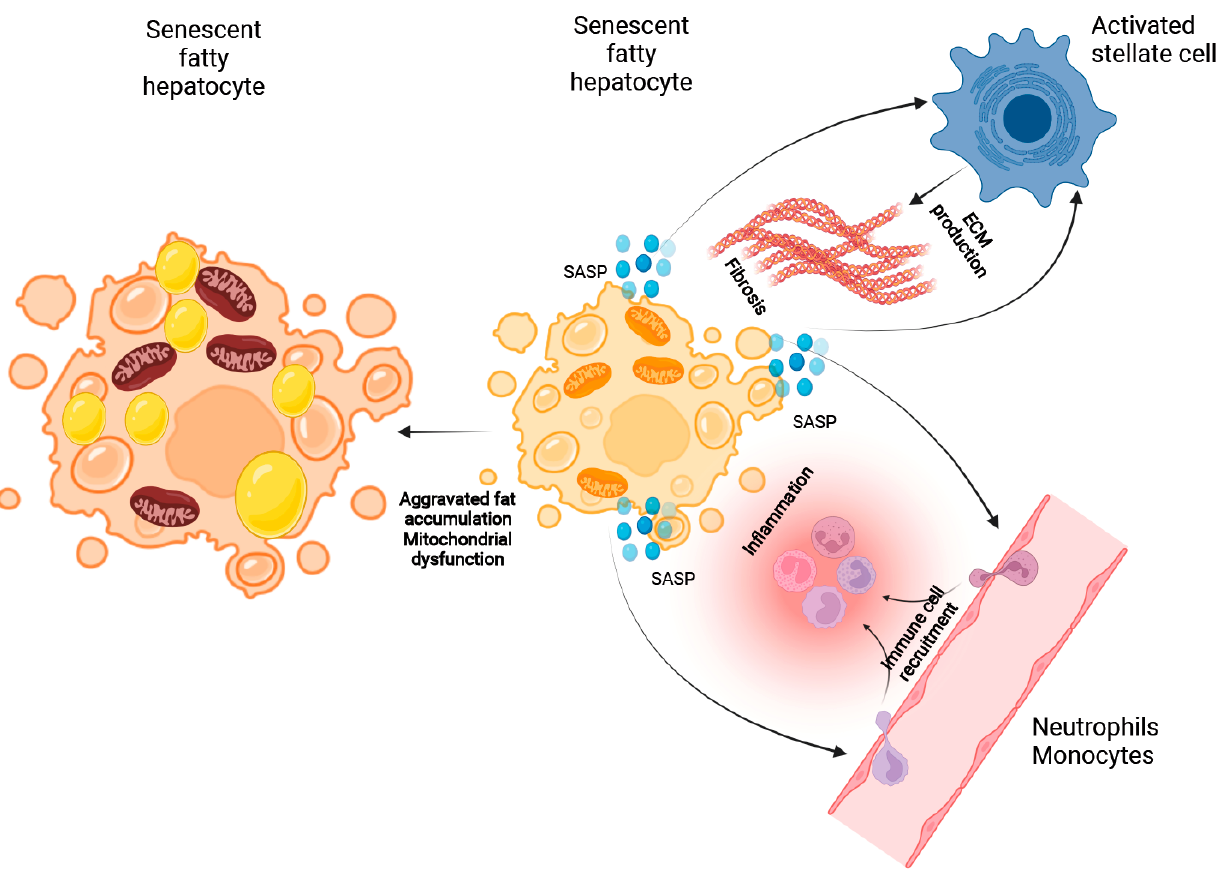
Figure 3. The potential role of cellular senescence in NAFLD progression. Hepatocellular senescence and mitochondrial dysfunction may aggravate fat accumulation in hepatocytes. The senescence- associated secretory phenotype (SASP) initiates recruitment of monocytes and neutrophils, thereby inducing inflammation and transition to NASH. In the same manner, SASP activates hepatic stellate cells leading to fibrogenesis.